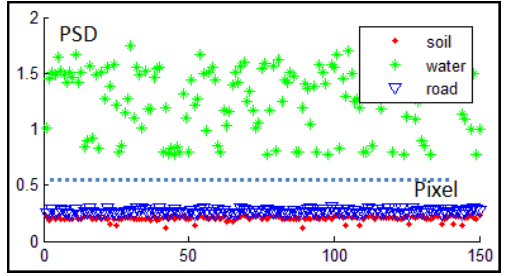
Figure 8. The PSD of 150 samples in the soil/road/water